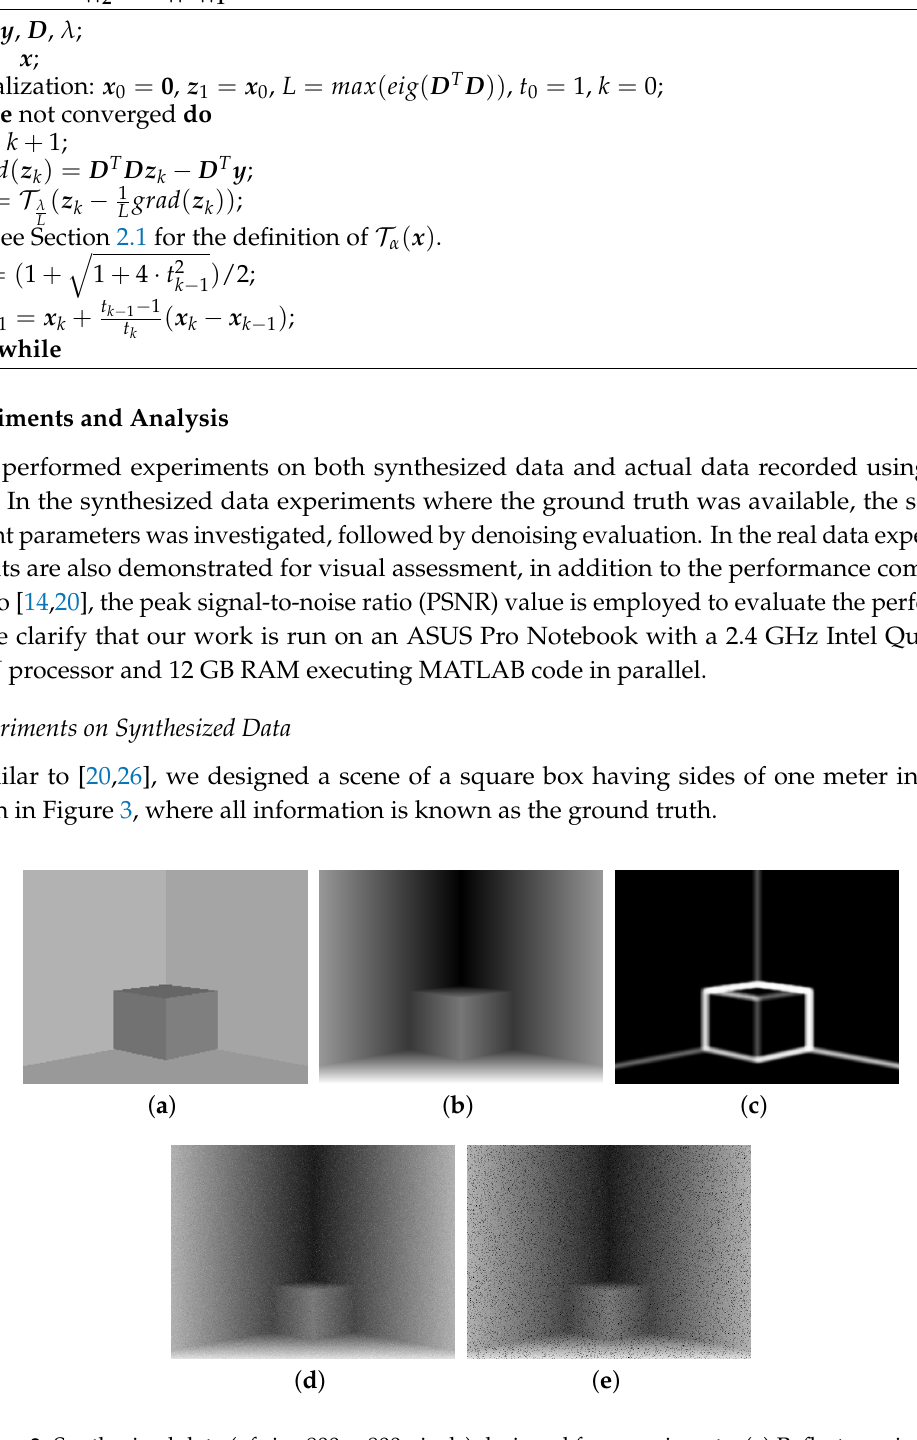
Figure 3. Synthesized data (of size 800 × 800 pixels) designed for experiments. ( a ) Reflectance image. ( b ) Depth map. ( c ) Result of informative-level estimation. ( d ) Gaussian noise-corrupted depth data. ( e ) Gaussian noise and outliers-corrupted depth